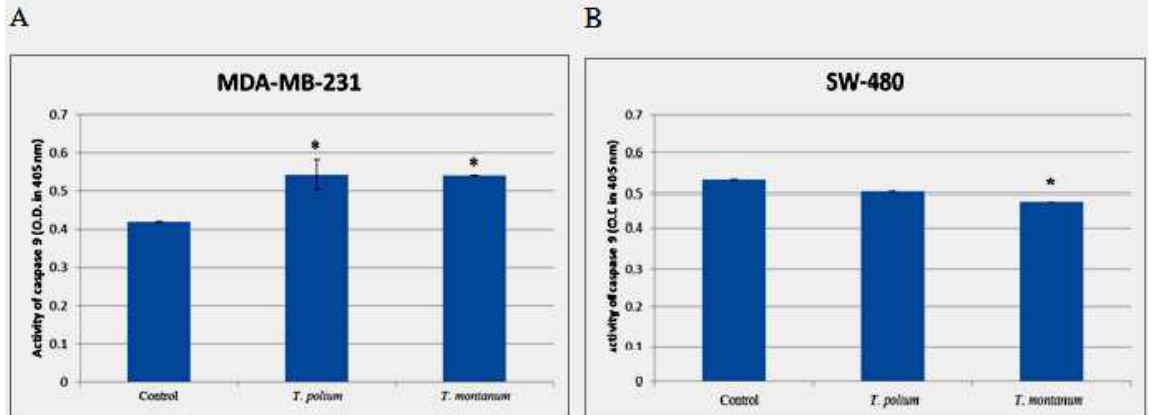
Figure 6. Caspase 9 activity in MDA-MB-231 (A) and SW-480 (B) control cells and cells treated by T. polium and T. montanum extracts. Cells were incubated with treatments for 24 h. Results are expressed as means ± SE for three independent determinations. *P < .05 compared to untreated